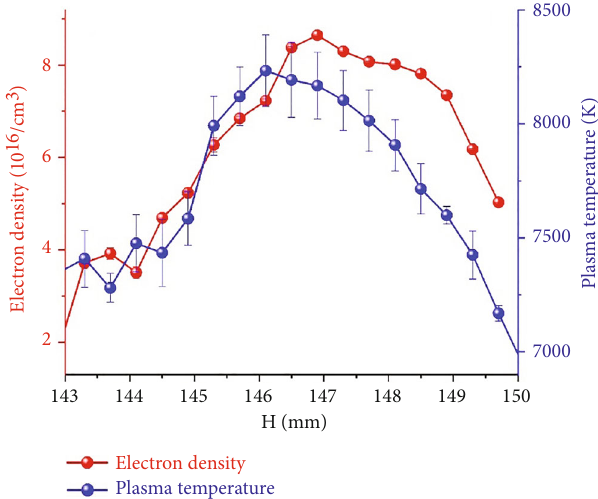
Figure 8: Evolution of electron density and plasma temperature at di ff erent H